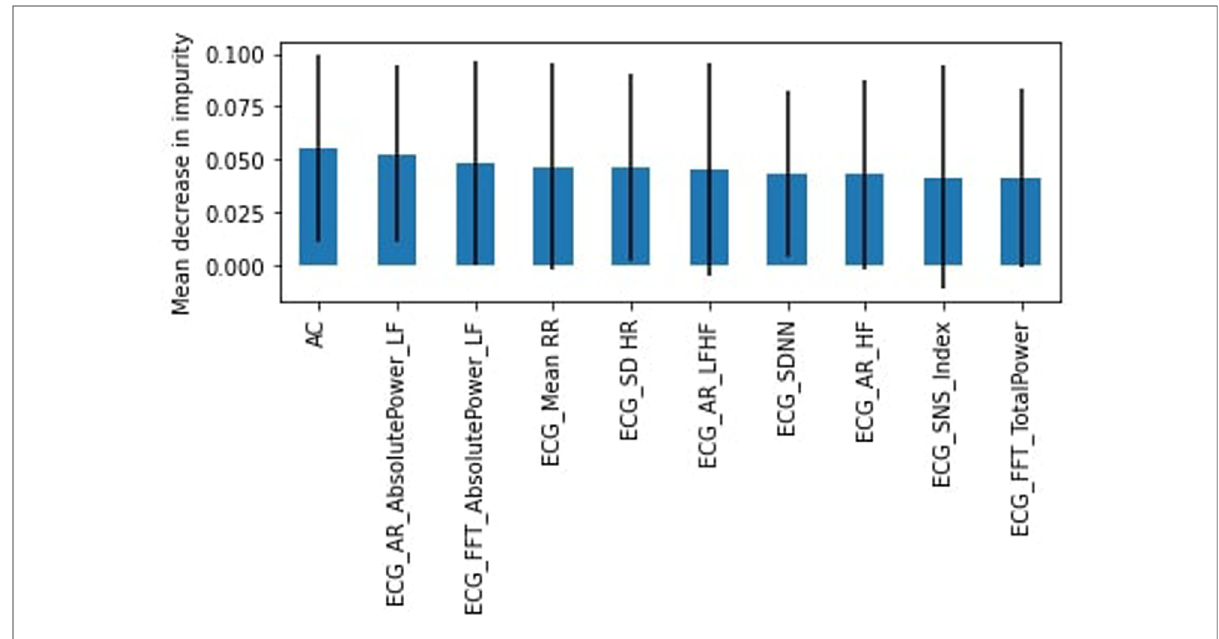
FIGURE 8 RF feature importance, subjects aged 45 – 64.